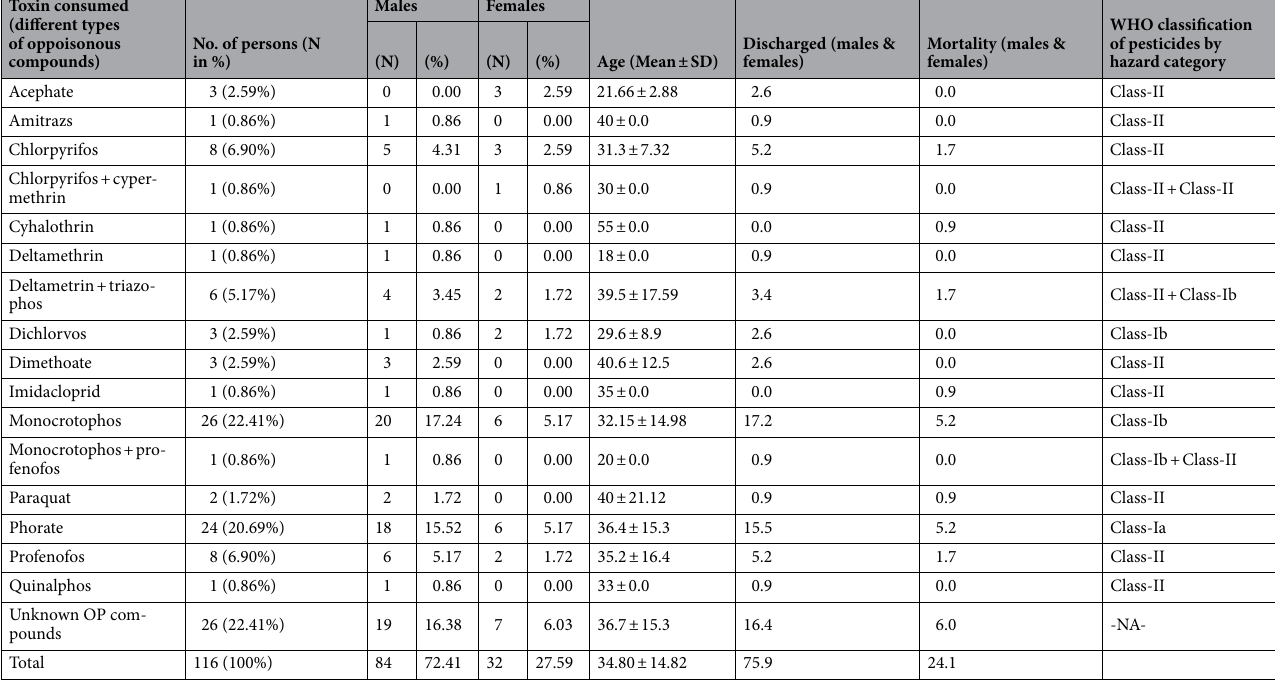
Table 1. Study description and comparative analysis of OP-poisoned individuals (N = 116) who ingested different types of OPs, based on the WHO Recommended Classification of Pesticides by Hazard. Class Ia, Extremely hazardous; Class Ib, Highly hazardous; Class II, Moderately hazardous.